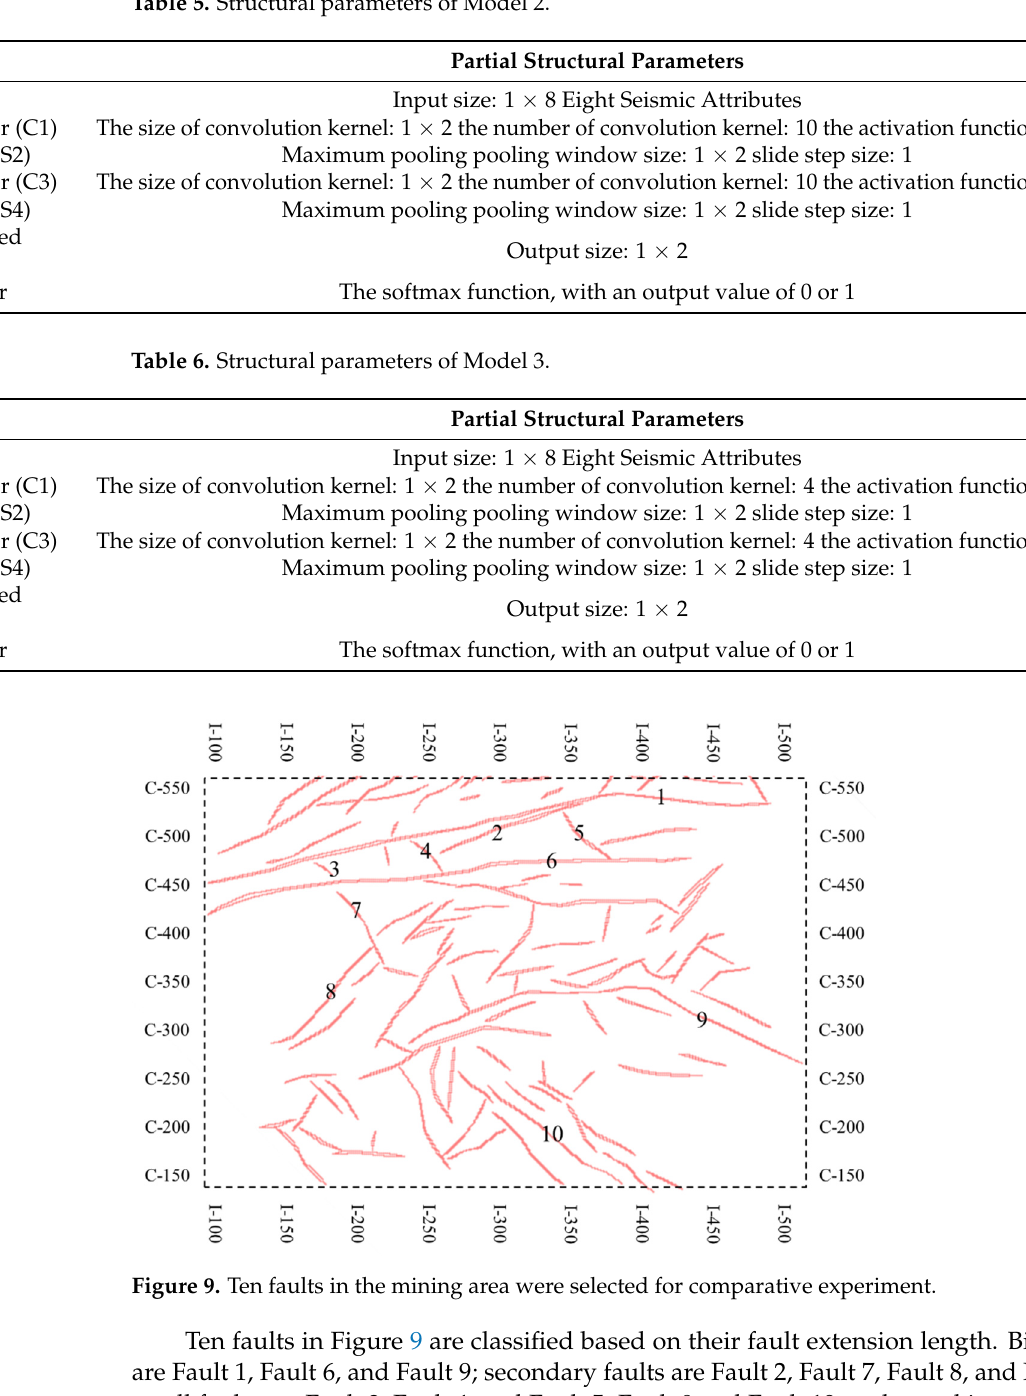
Figure 10. Prediction result of Model 1. The prediction result of Model 2 is depicted in Figures 11 and 12. The prediction effect of Model 2 on Faults 1–8 is excellent, with only a small portion missing in the rear segment of Fault 1, and the continuity of the right end of Fault 6 is slightly worse than its left end. Faults 9 and 10 remain unknown. As shown in Figure 13, Model 3 can only show Fault 1 and Fault 6, and other faults cannot be predicted. By comparing and analyzing the prediction impacts of the three models, it is discov- ered that the fault identification effect of Model 2 is much better than that of Model 1 and Model 3, and the continuity is excellent. Model 1 has a few faults, but the prediction points are scattered, and the continuity needs improvement. The continuity of Model 3 ′ s fault prediction results is more consistent than that of Model 1, yet Model 3 could predict too few faults. Therefore, it is speculated that the network structure of Model 1 is too complex for this dataset, and there may be an over-fitting effect lowing the prediction level. In ad- dition, the structure of Model 3 is oversimplified, resulting in a poor prediction effect. Under the same dataset, Model 2 is more suitable for fault prediction.